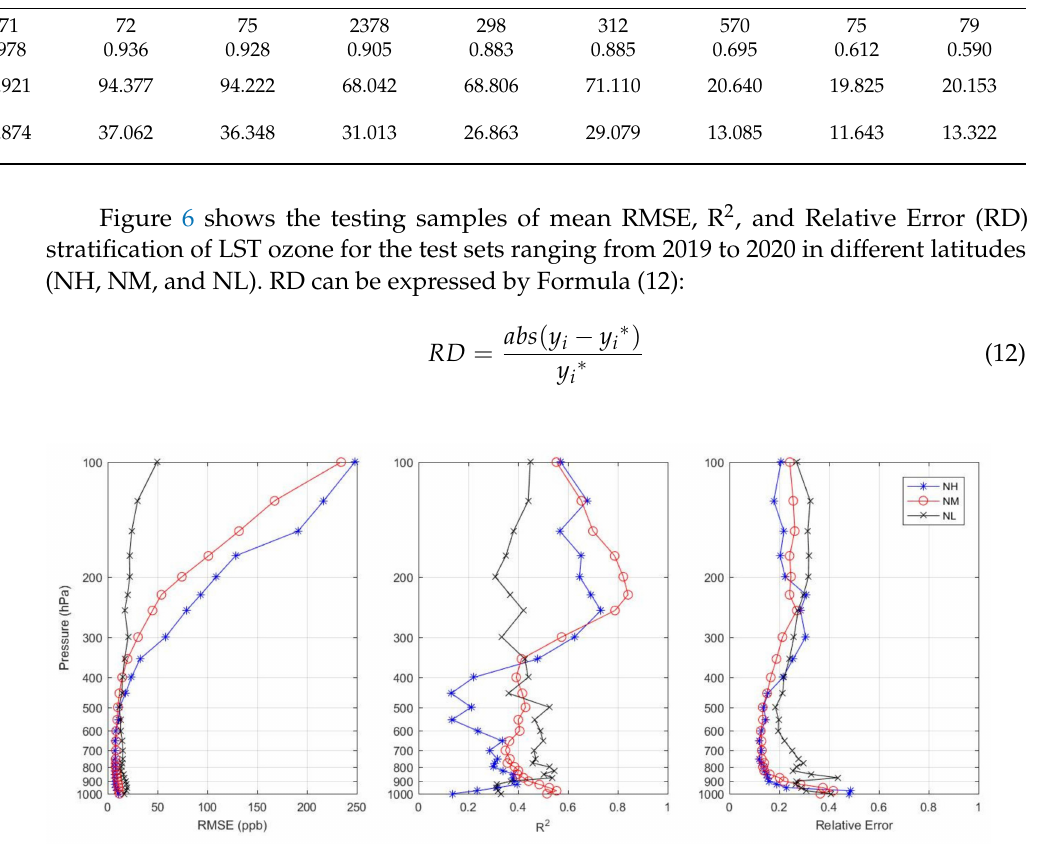
Figure 6. RMSE, R 2 , and relative error stratification of tropospheric ozone on test sets in the Northern